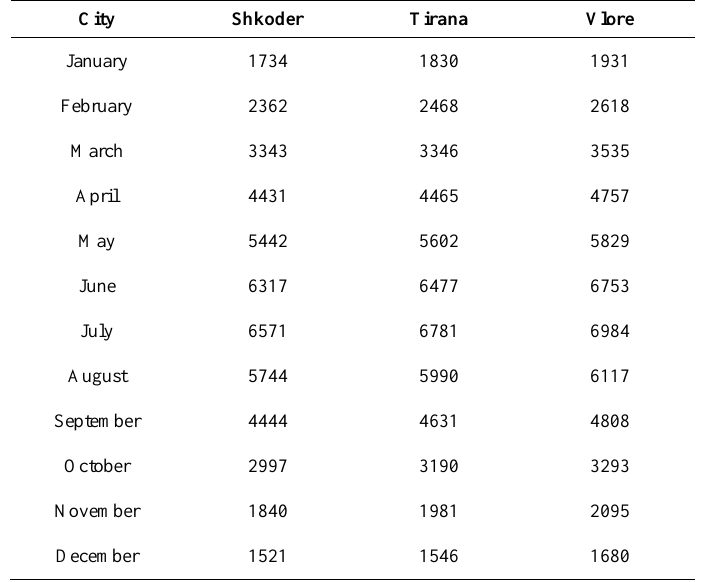
Table 1. The daily average of solar irradiance for some City in Albania (W/m 2 ).